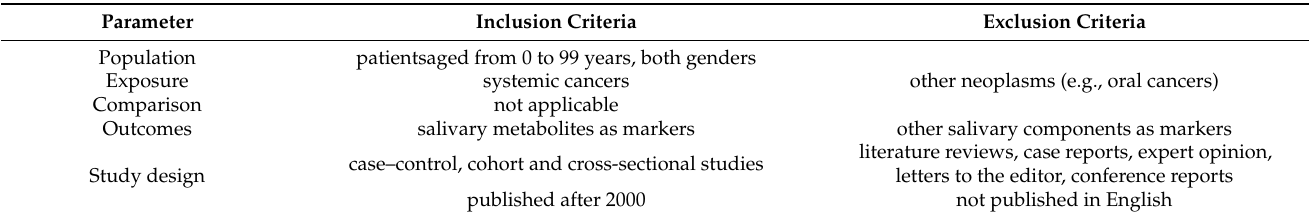
Table 1. Inclusion and exclusion criteria according to the PECOS.